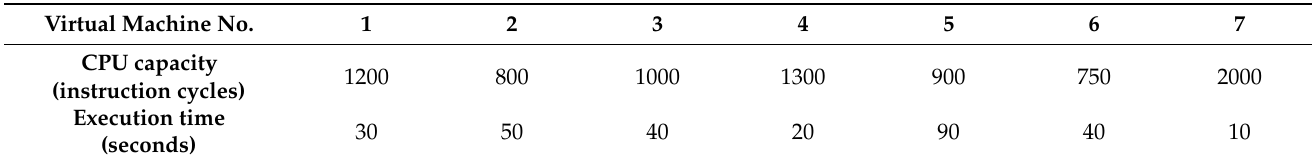
Table 7. Configuration of 7 virtual machines for scenario 5.